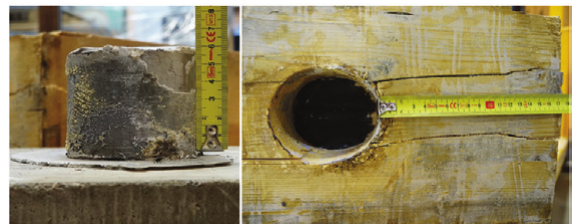
Fig. 12. D76 concrete sample failure (steel intact, wood in compression and shear along the